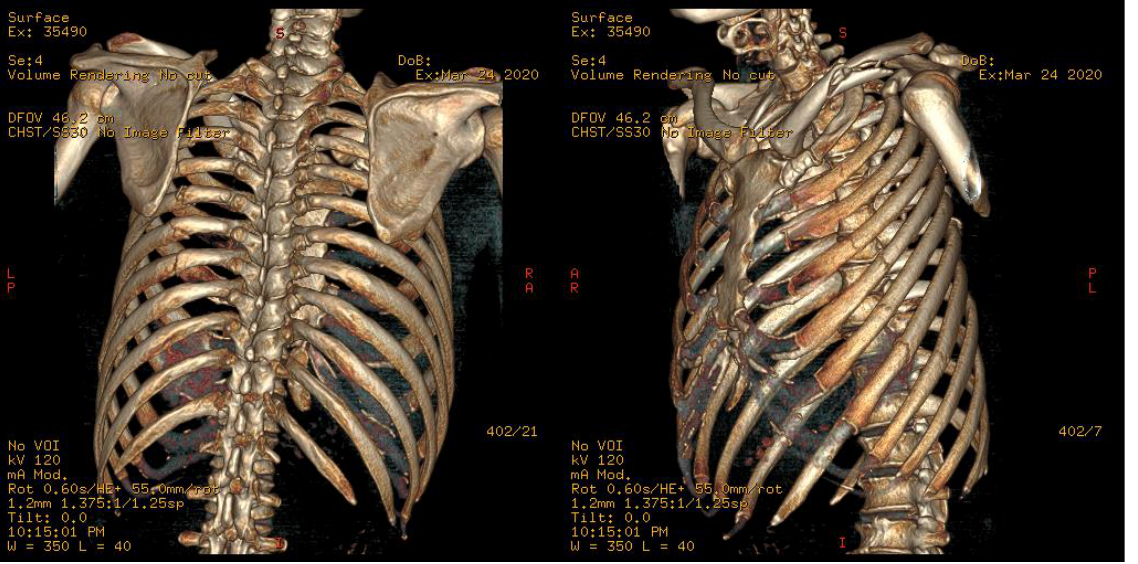
Figure 1. 3D Chest CT scan depicting multiple fractures involving left middle clavicle and left 2nd–8th ribs. Flail fragments were noted over the 4th–8th ribs.